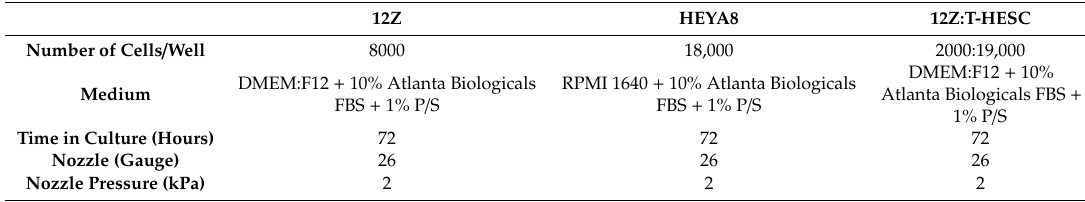
Table 1. Biofabrication conditions for cell lines.